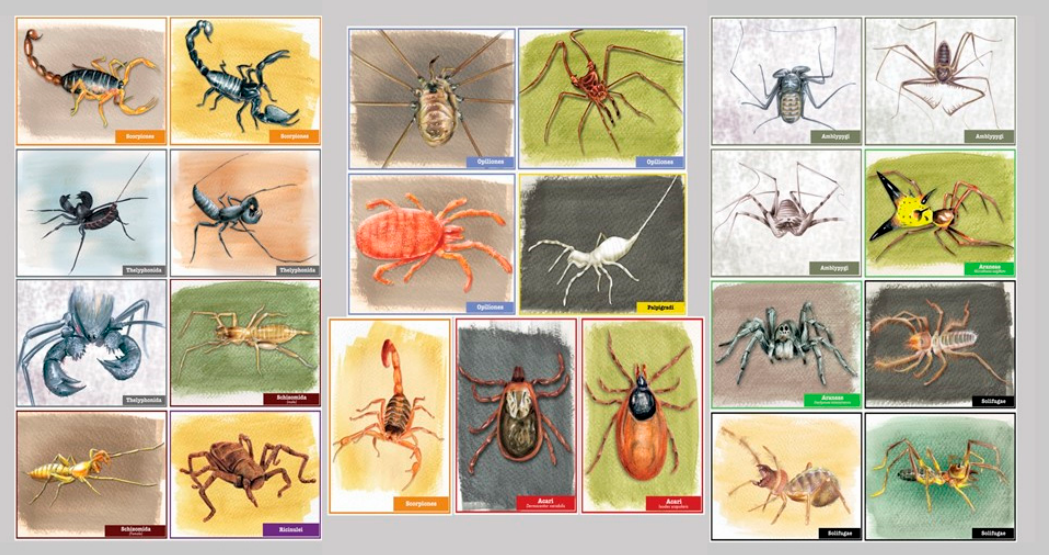
Figure 3. Original artwork trading cards were handed out to youth following the completion of the Path of Predators activities. Youth were able to choose one of two or three different designs. The backs of each card had information regarding the following topics: Order name; Common Name (when available); Habitat; and Fun Fact.